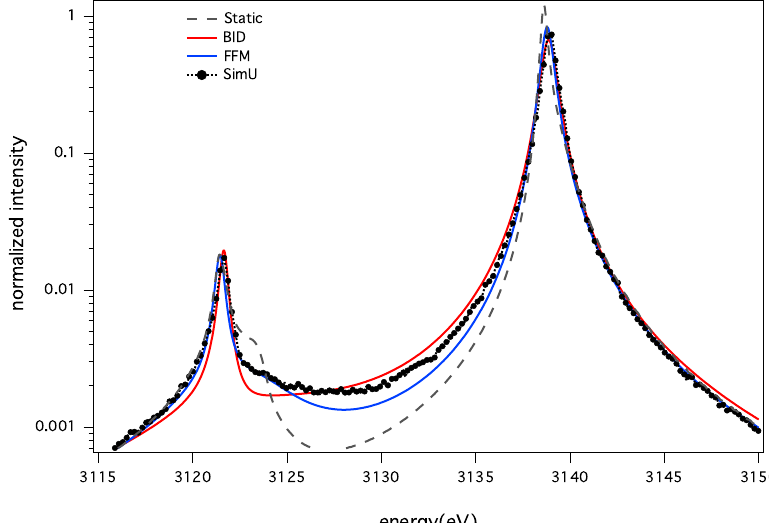
Figure 7. The He- (cid:11) line for T = 1 keV and n dash); ion dynamics BID (solid red); FFM (solid blue) and SimU (black